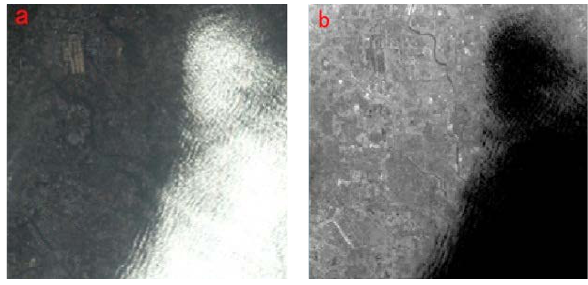
Figure 3. (a)True-color composite image (SceneID:E116.9_N 40.1_20161105). (b) Result of RSB